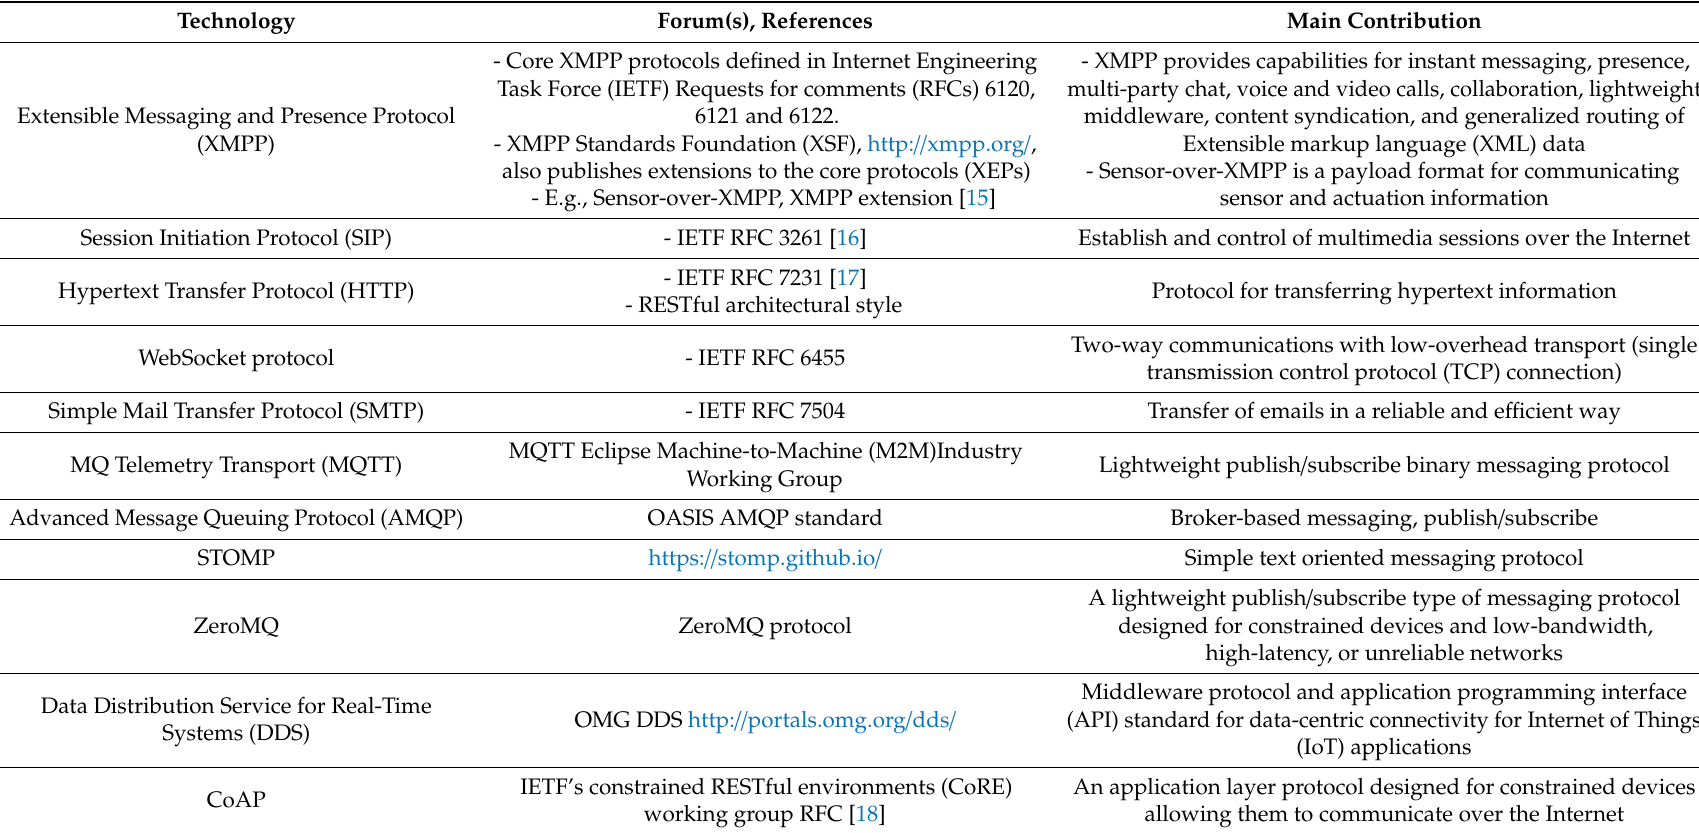
Table 1. Review of communication overlay